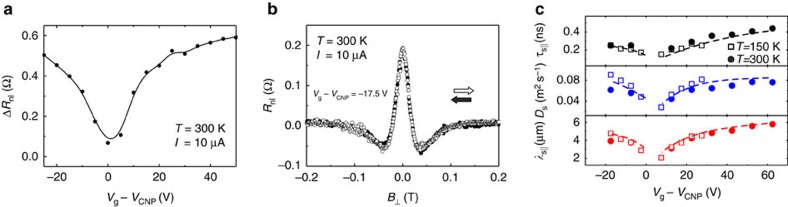
Spin precession under perpendicular magnetic field.(a) Non-local resistance Rnl change, , as a function of gate voltage Vg. The values of ΔRnl are extracted from Rnl versus in-plane magnetic field measurements and reflect the change in the signal when the relative magnetization of the ferromagnetic electrodes switches from parallel (↓↓,↑↑) to antiparallel (↓↑) configuration. The line is a guide to the eye. (b) Conventional spin precession measurements with perpendicular magnetic field B⊥ for up (open symbols) and down (solid symbols) sweeps. Complete spin dephasing occurs for field strengths larger than Bd∼0.1 T. (c) In-plane spin-relaxation time , spin-diffusion coefficient Ds and spin-relaxation length , obtained from the spin precession measurements in b. The dashed lines are a guide to the eye. The measurements in a,b are performed in the non-local configuration. The error bars are smaller than the symbol size. The errors correspond to the standard error of mean obtained from the fitting for Ds and , and the propagated error for .